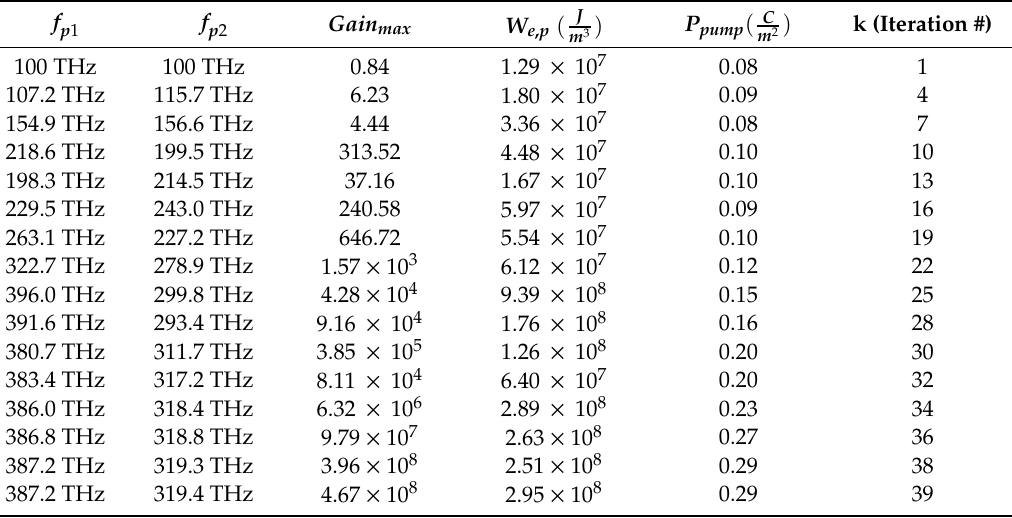
Table 1. BFGS algorithm-based optimization